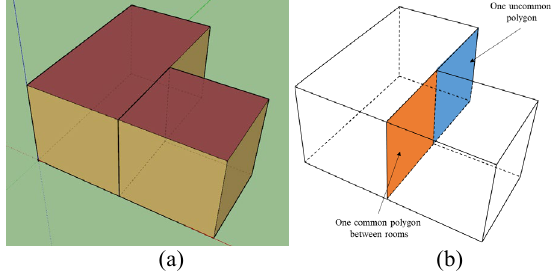
Figure 9. Scenario 2 result. (a) SketchUp visualization; (b) Schema